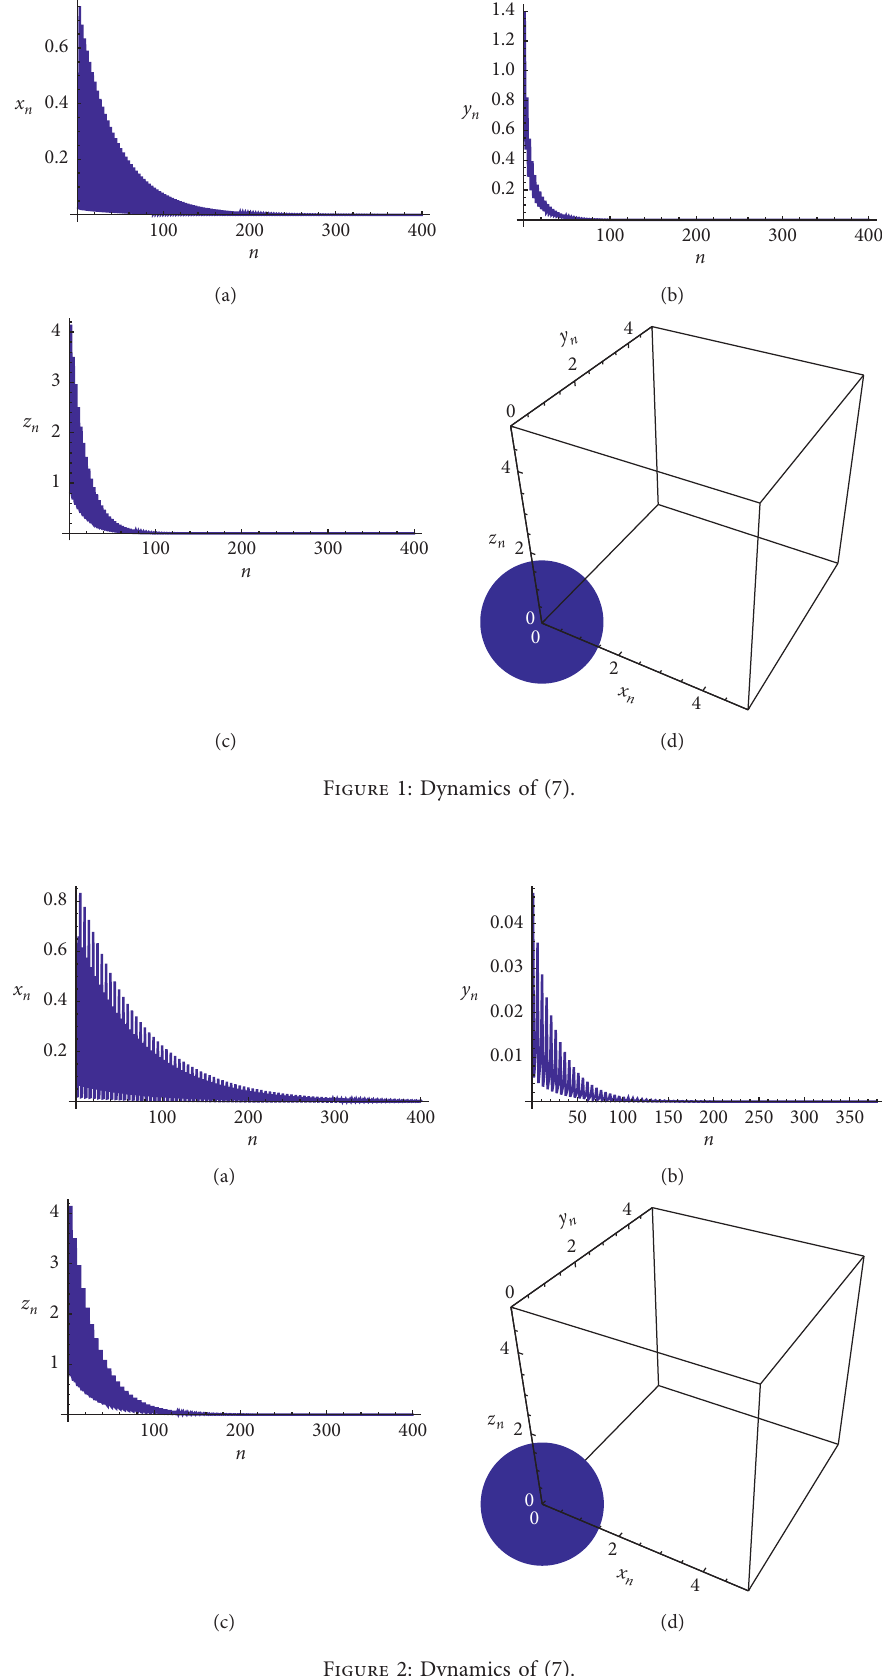
Figure 1: Dynamics of (7).